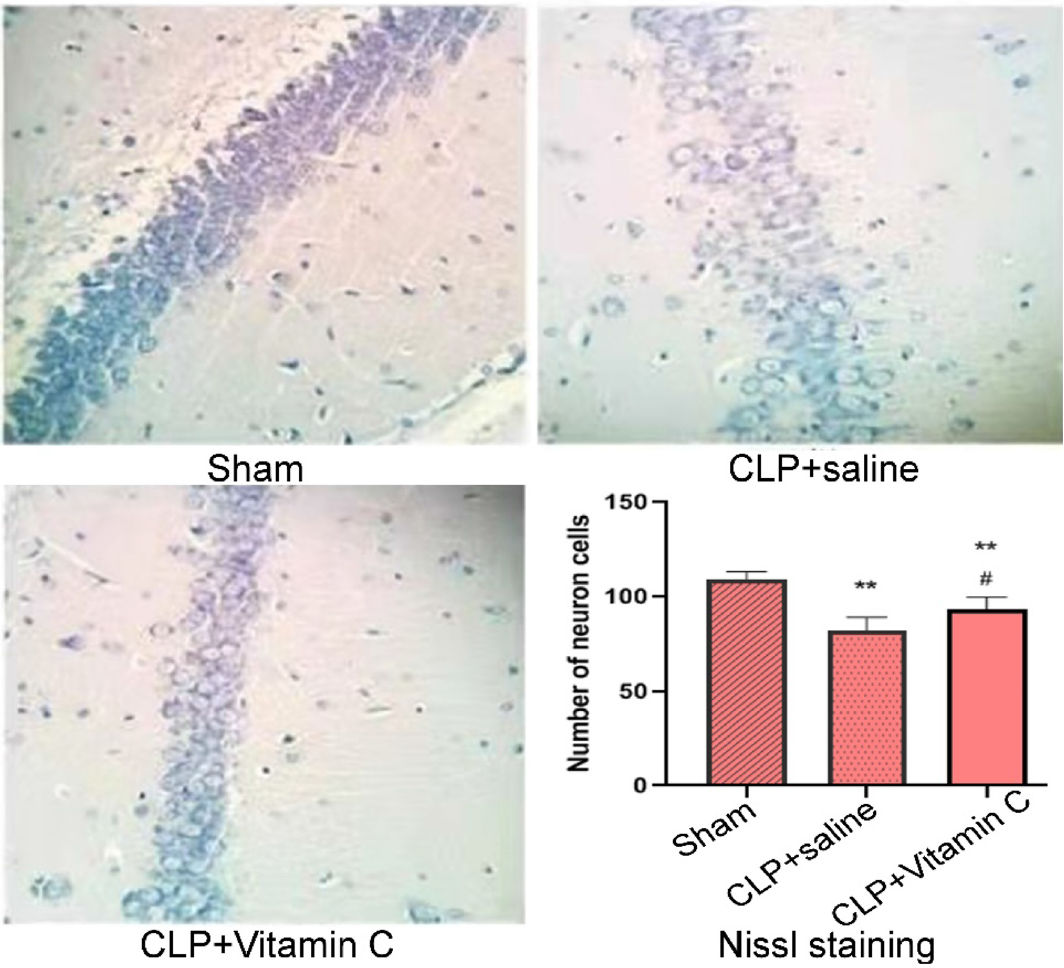
Figure 2. Nissl staining in the hippocampal CA1 region. Representative sections from the hippocampal CA1 region were observed 24 h after operation (Nissl staining × 200). The pyramidal neurons in the hippocampal CA1 region were significantly decreased (P = 0.000) in both the CLP + saline group and the CLP + vitamin C group compared with the sham group. Compared with the CLP + high-dose vitamin C group, the pyramidal neurons in the CLP + saline group were significantly (P = 0.01) decreased. * P < 0.05 and ** P < 0.01 compared with sham group; # P < 0.05 compared with the CLP group. CLP, cecal ligation and puncture. Statistical value: 24.69, total degree of freedom: 14, P: